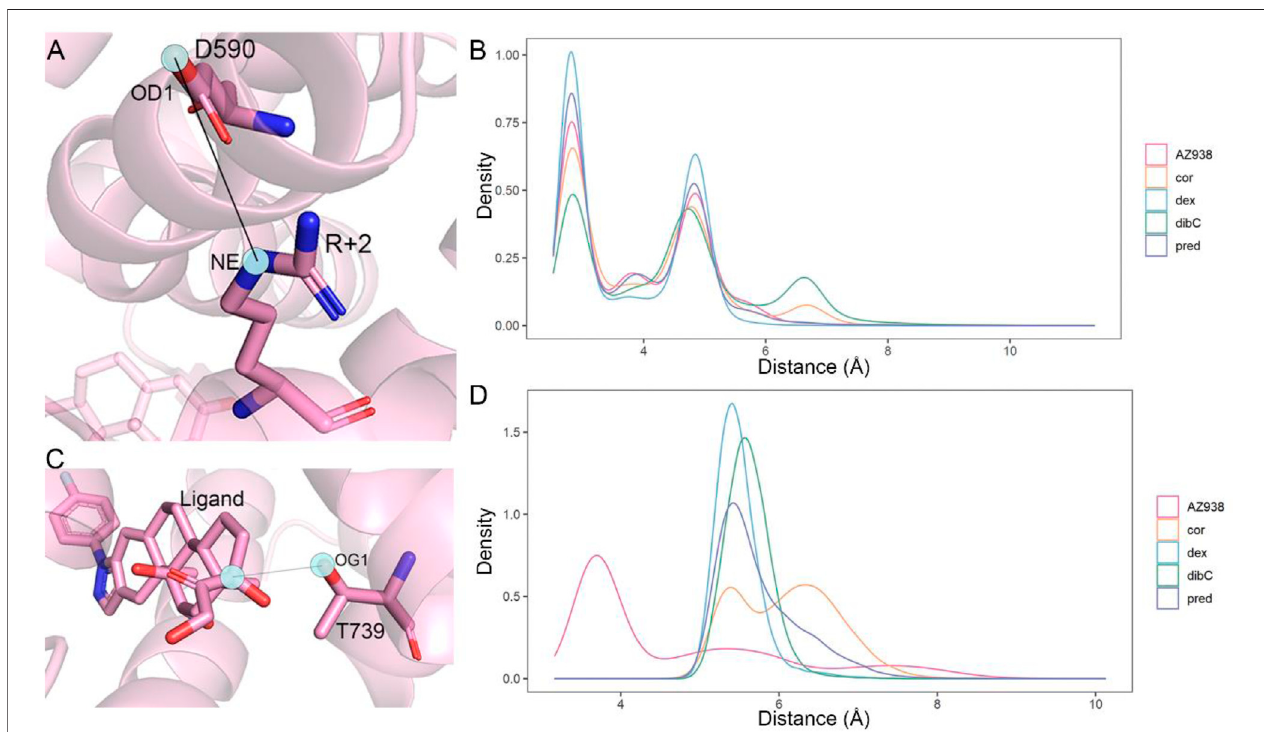
FIGURE 7 | Distance measurement of two pairwise atoms. (A) cartoon representation of the distance between OD1 in D590 and R+2 in NE. (B) distance distribution density of D1 in D590 and NE in R+2 in fi ve systems. (C) cartoon representation of the distance between OG1 in T739 and the C atom in agonists. (D) distance distribution density of OG1 in T739 and corresponding C atoms in each agonist (C25 in the AZ938-bound system, C15 in the dibC-bound system, C18 in the pred-bound system, and C17 in dex- and cor-bound